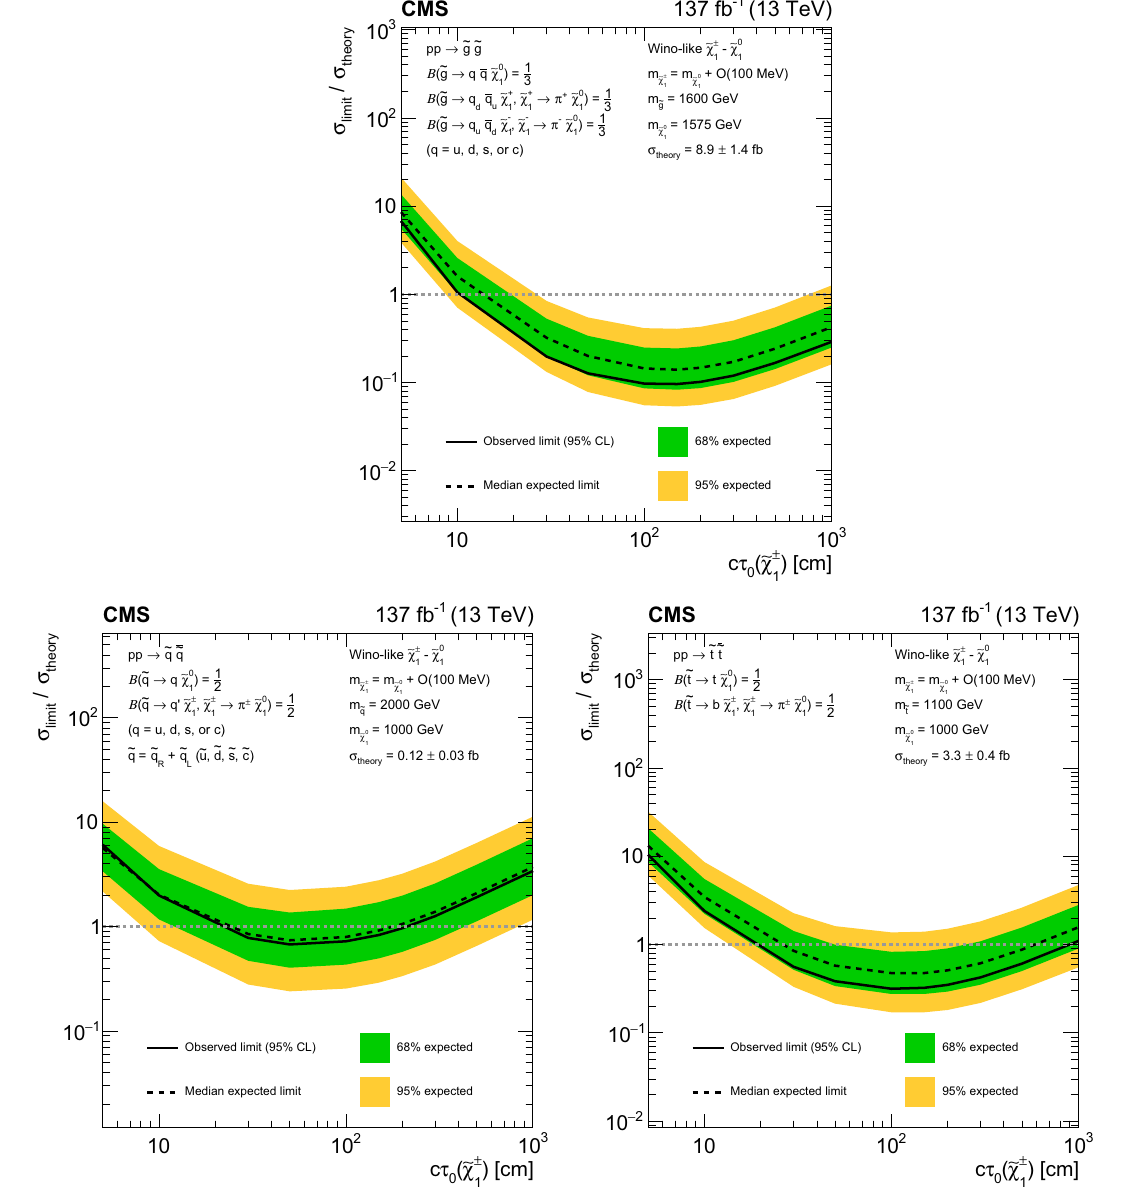
Fig. 22 Exclusion limits at 95% CL on σ/σ theory as a function of decay length, for a choice of signal models of (upper) direct the ˜ χ ± 1 gluino pair production where the gluinos decay to light-flavor (u, d, s, c) quarks, (lower left) direct light-flavor squark pair production, and (lower right) direct top squark pair production, as obtained from the search for disappearing tracks. The area enclosed by the solid (dashed) black curve belowthe horizontal dashed line at σ/σ theory = 1 represents